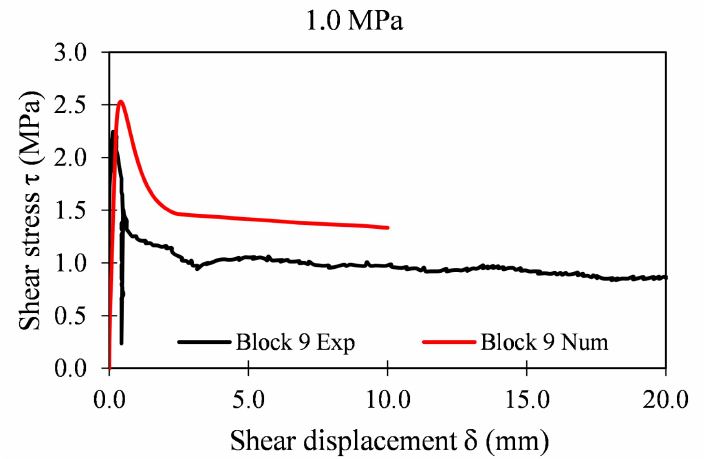
Figure 29. Shear stress evolution with displacement Exp–Num (Block 6).